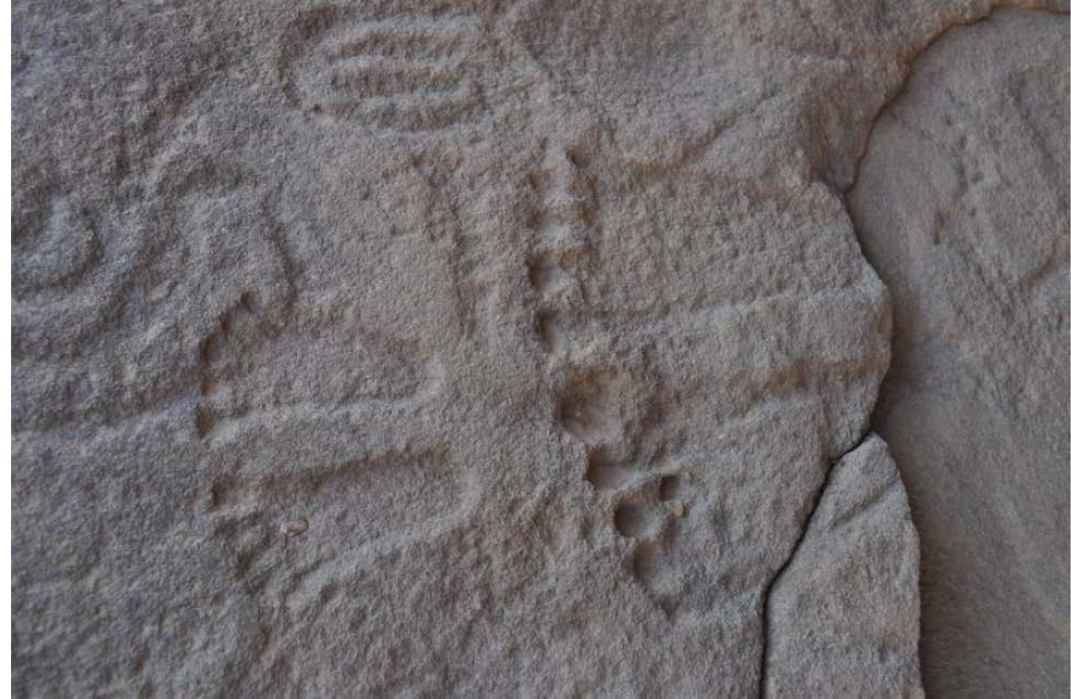
Figure 24. Some of the human footprints at Jabal al-Raat,